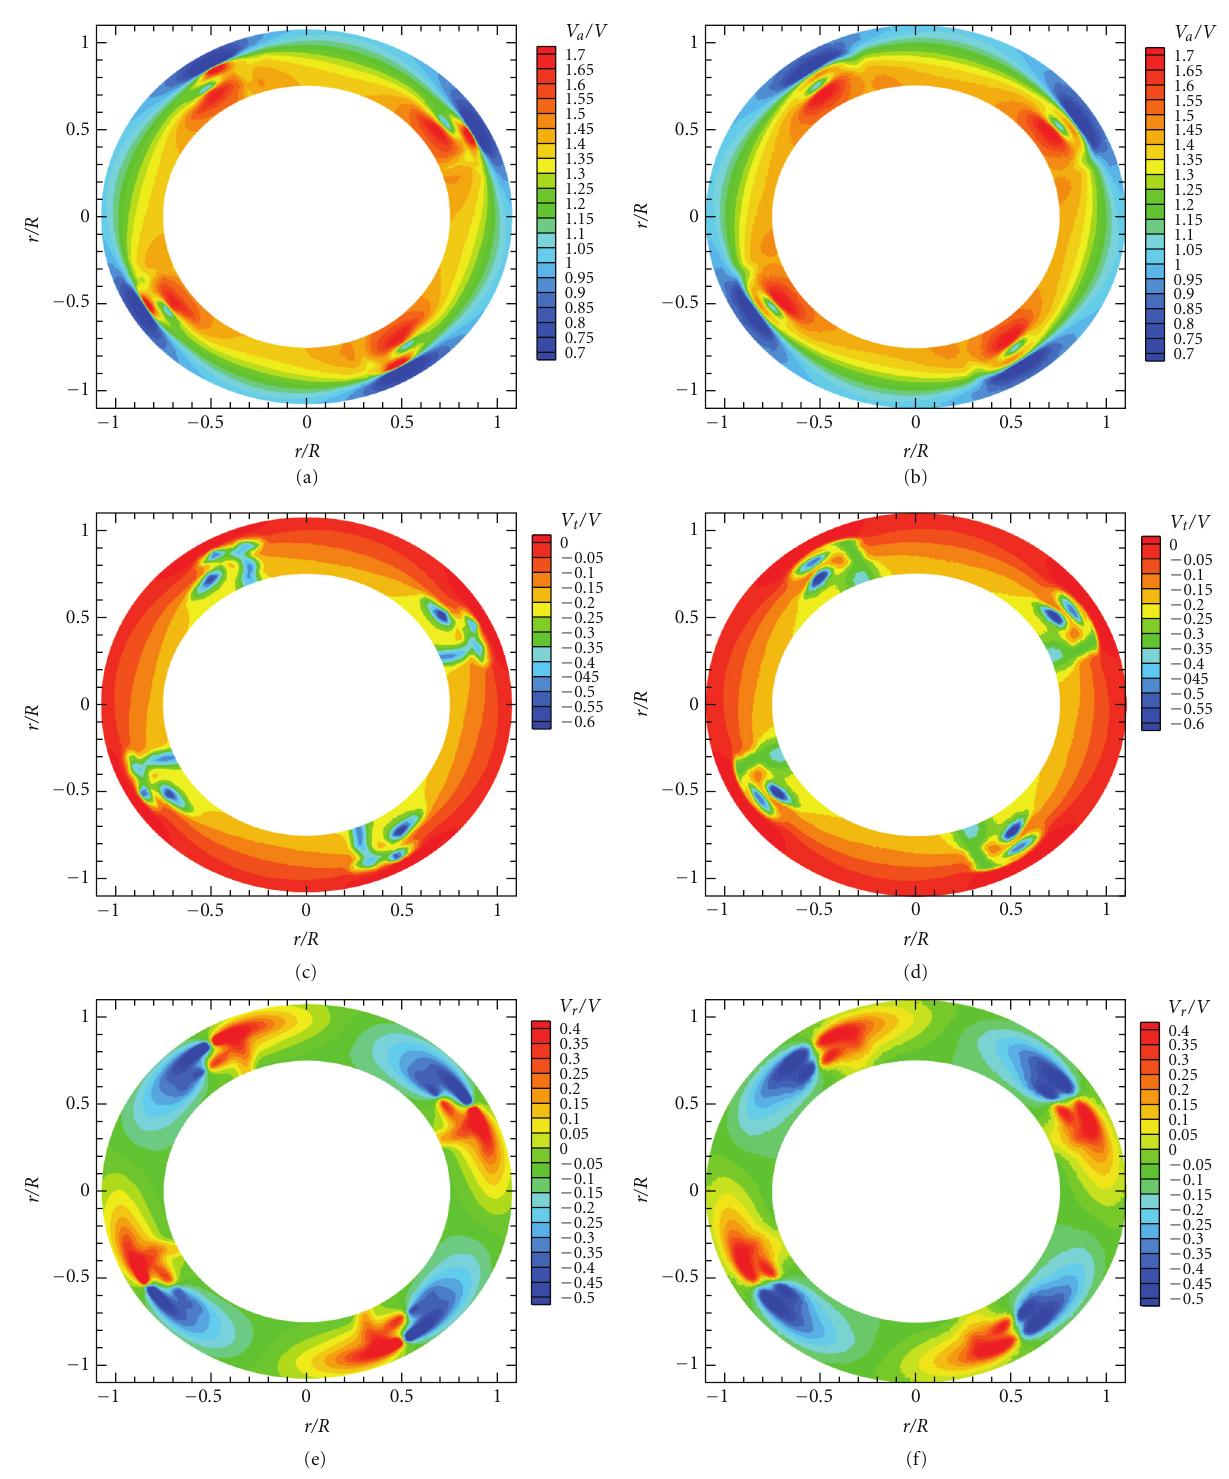
Figure 18: Axial, tangential, and radial nondimensional velocity distributions at x/R = 0.7000 aft the propeller plane. ((a), (c), and (e)) Experimental LDV measurements. ((b), (d), and (f)) RANSE computations on the finer